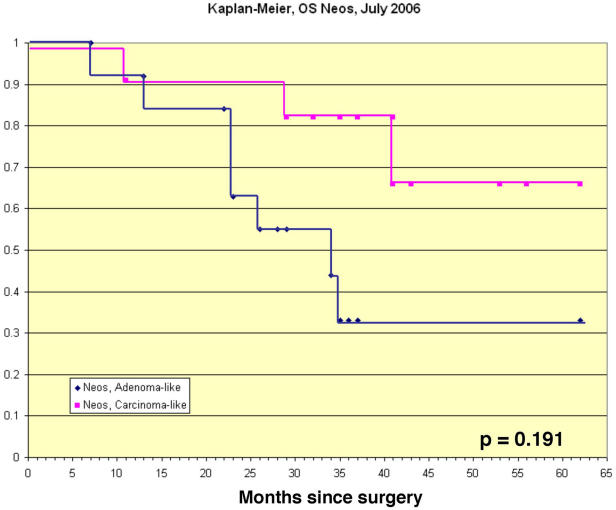
Cumulative survival curves of ovarian carcinoma patients treated with neo-adjuvant chemotherapy.Seventy percent of neo-adjuvant cancer patients whose tissue gene expression profiles clustered with those of cancer patients not pre-treated with chemotherapy have survived five years after surgery. In contrast, only thirty percent of patients whose expression arrays clustered with benign adenoma patients prior to surgery survived five years after surgery. Although the trends are clear, because of the limited sample size of the cohort of patients for which follow-up data were available (A-L group n = 13; C-L group n = 11), the differences are marginally insignificant (p<0.191, logrank test). The survivorship data used in the computation of the Kaplan-Meier plot can be found in the supplementary material (Figure S2).